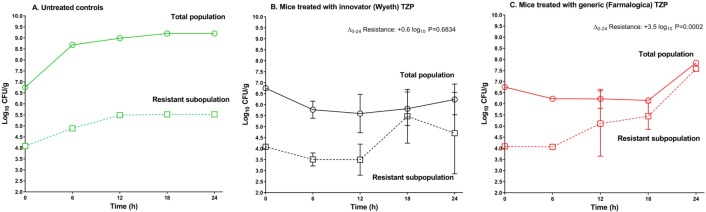
Time course of resistance enrichment in vivo by innovator (Wyeth) and generic (Farmalogica) TZP at 640 mg/kg per day.Population dynamics of the total mixed population (circles and continuous lines) and the resistant subpopulation (squares and dotted lines), after in vivo exposure in neutropenic mice to 640 mg/kg per day. Two mice were sacrificed at each time-point except for the last one (24h) where 3 animals were used. A. Untreated controls (green), the total population grew 2.44 log10 CFU/g, and the resistant one 1.44 log10 CFU/g. B. Innovator TZP treatment group (black), the resistant subpopulation started to expand after the 12th hour, at the end of the experiment it had increased in average 4-times compared with initial numbers, a nonsignificant difference (P = 0.6834). C. Generic Farmalogica TZP treatment group (red), the resistant subpopulation began to expand after 6 hours, increasing in average 3162-fold at the end of therapy (P = 0.0002). Resistance enrichment with the nonequivalent generic was at least 800-times higher than with the innovator. The symbols represent the mean bacterial burden and the error bars the standard deviation (log10 CFU/g).